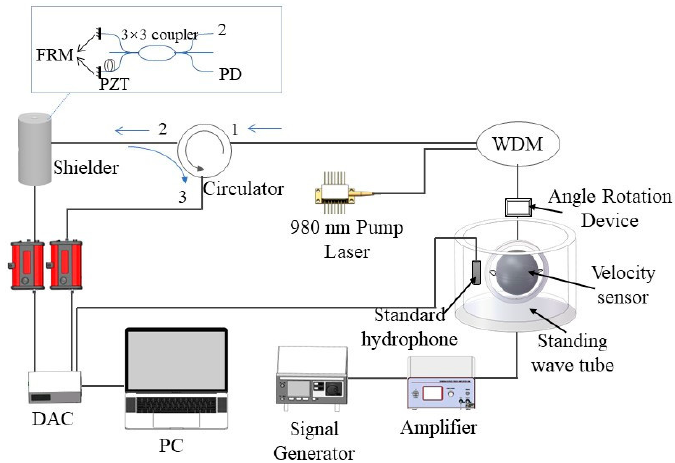
Figure 11. The experimental setup for phase sensitivity of the sensor. The experimental results without castor oil in the sphere are shown in the blue curve of Figure 12a. The measured phase sensitivity is approximately − 190.6 dB (0 dB = 1 rad/ μ Pa) at 20 Hz. However, there is a resonance peak at 100 Hz, which is 26 Hz lower than the unpackaged. This may be attributed to the sound–structure coupling effect.